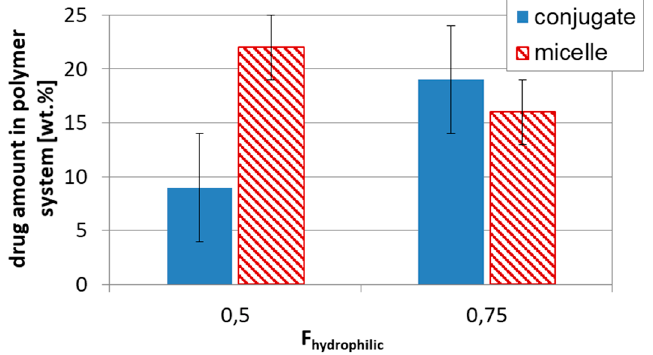
Figure 6. Influence of drug loading type, conjugates DGL1 vs. micelles DGL3, on drug content in respect to hydrophilic–hydrophobic balance.